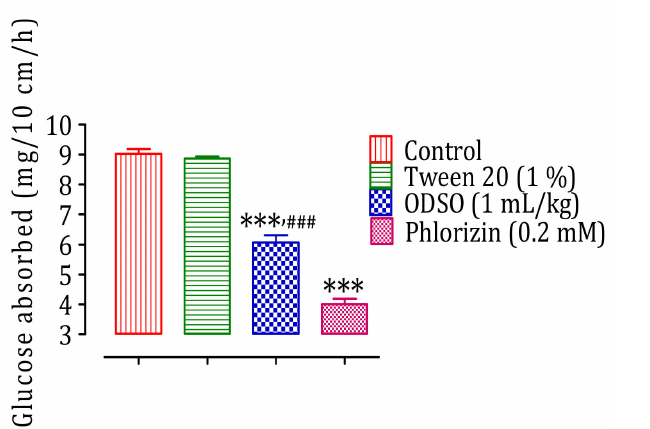
Figure 4. Inhibitory effect of the intestinal absorption of D -glucose by oil (ODSO) and phlorizin in situ. ODSO: Opuntia dillenii seed oil. The values are the means ± SEM ( n = 6). *** p < 0.001 compared to the control and ### p < 0.001 compared to the Phlorizin